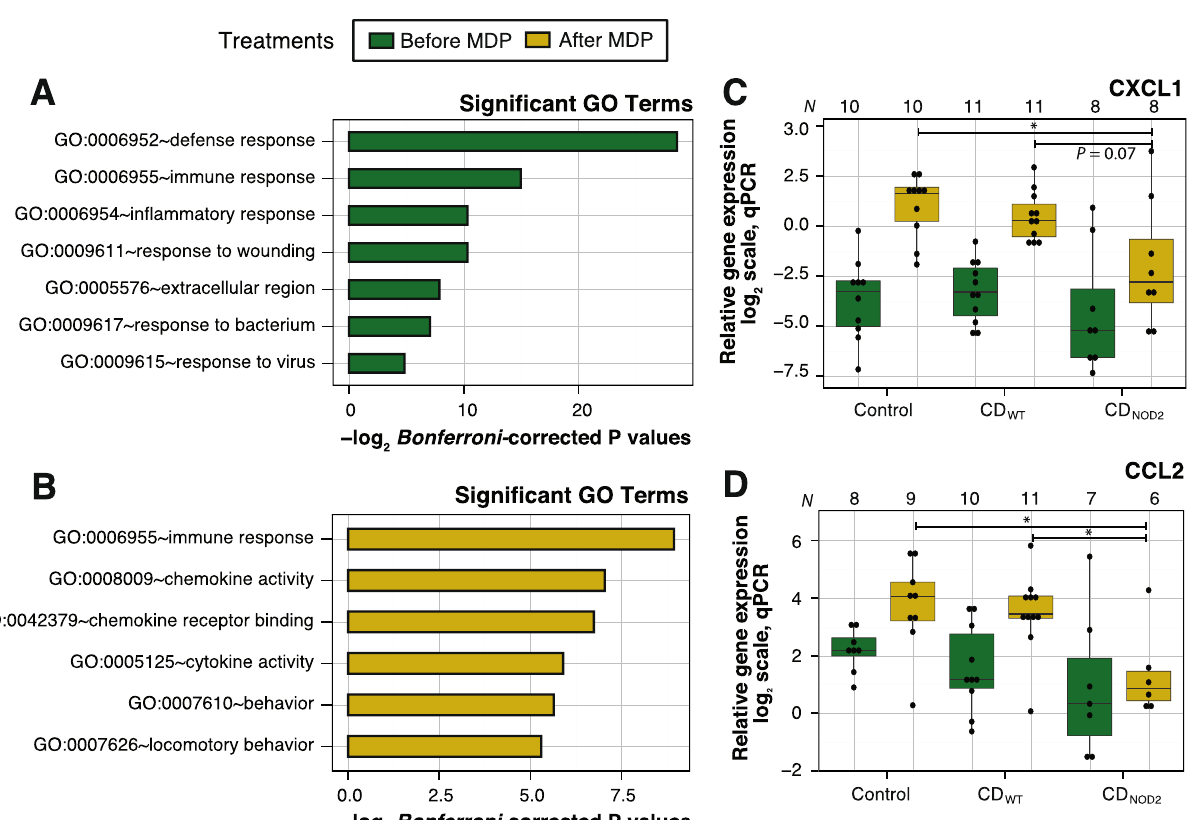
Fig. 3 Functional annotation of differentially expressed genes between subject groups. a Enriched signi fi cant GO terms ( Bonferroni-corrected P-values ≤ 0.05) for differential expressed genes between subject groups before MDP treatment. X -axis shows – log 2 (Bonferroni-corrected P- values) and Y -axis shows GO terms. b As in a , but showing signi fi cant GO terms for differential expressed genes between subject groups after MDP treatment. c qPCR validation for a selected chemokine, CXCL1 , which exhibits a large difference between the subject groups after MDP treatment. X -axis shows subject groups before ( dark green ) and after MDP treatment ( yellow ). Numbers on top of the plot indicate the number of biological replicates passing the qPCR thresholds. Each subject is visualized as black dots . Y -axis shows the relative gene expression in log 2 scale. Asterisks indicate level of signi fi cance (two-sided t -test): * indicates P ≤ 0.05, ** P ≤ 0.01, and *** P ≤ 0.001. A single comparison with a P -value close to the signi fi cance threshold is indicated. d qPCR validation for a selected chemokine, CCL2 , following the conventions of